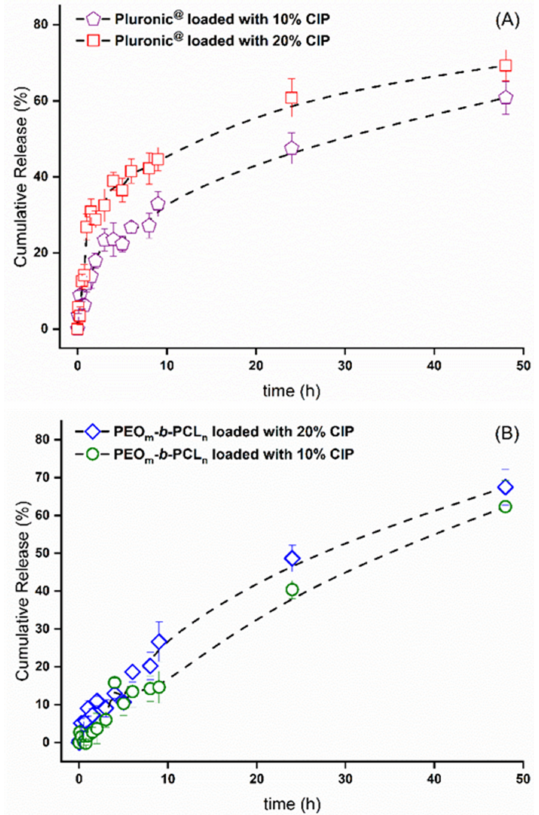
Figure 6. CIP release profile in best encapsulation conditions with ( A ) Pluronic P123/F127 and ( B ) PEO 113 - b -PCL 118 micelles. Error bars indicate the standard deviation of three replicates.